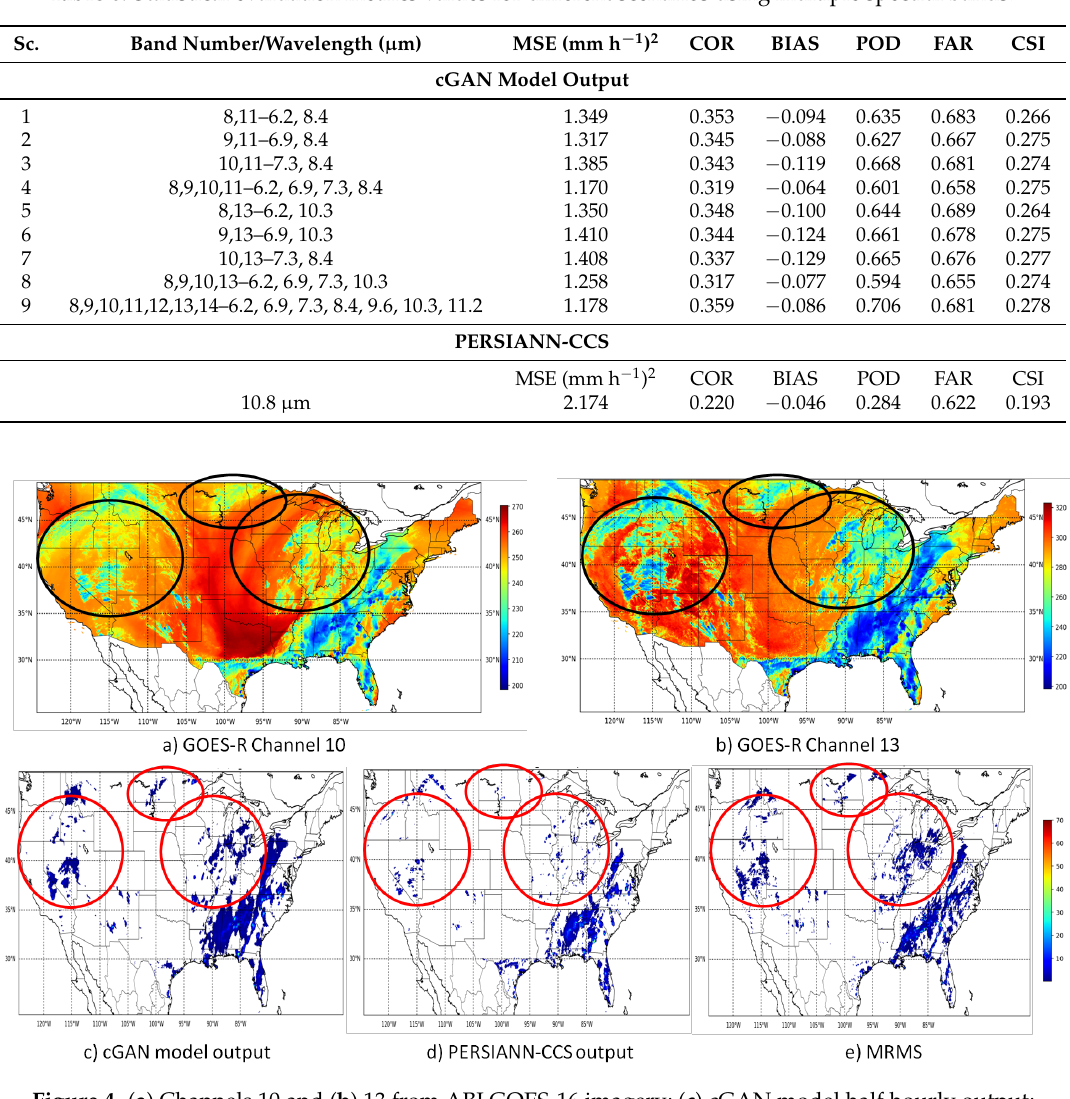
Figure 4. ( a ) Channels 10 and ( b ) 13 from ABI GOES-16 imagery; ( c ) cGAN model half hourly output; ( d ) PERSIANN-CCS half hourly precipitation values; and ( e ) The MRMS data for 31 July 2018 at 22:00 UTC over the CONUS.Black circles on GOES-16 satellite imagery represent regions with warm clouds and the red circles are the corresponding regions with the rainfall associated with the warm clouds. Daily and monthly values for all the models are also provided in Figure 5. As shown in the red circled regions for the precipitation values with daily scale in the left panel, the proposed cGAN model output is capturing more of the precipitation as compared to PERSIANN-CCS output. Although both models are showing overestimation compared to MRMS in monthly scale, precipitation values from the proposed model are closer to the ground truth extreme values than